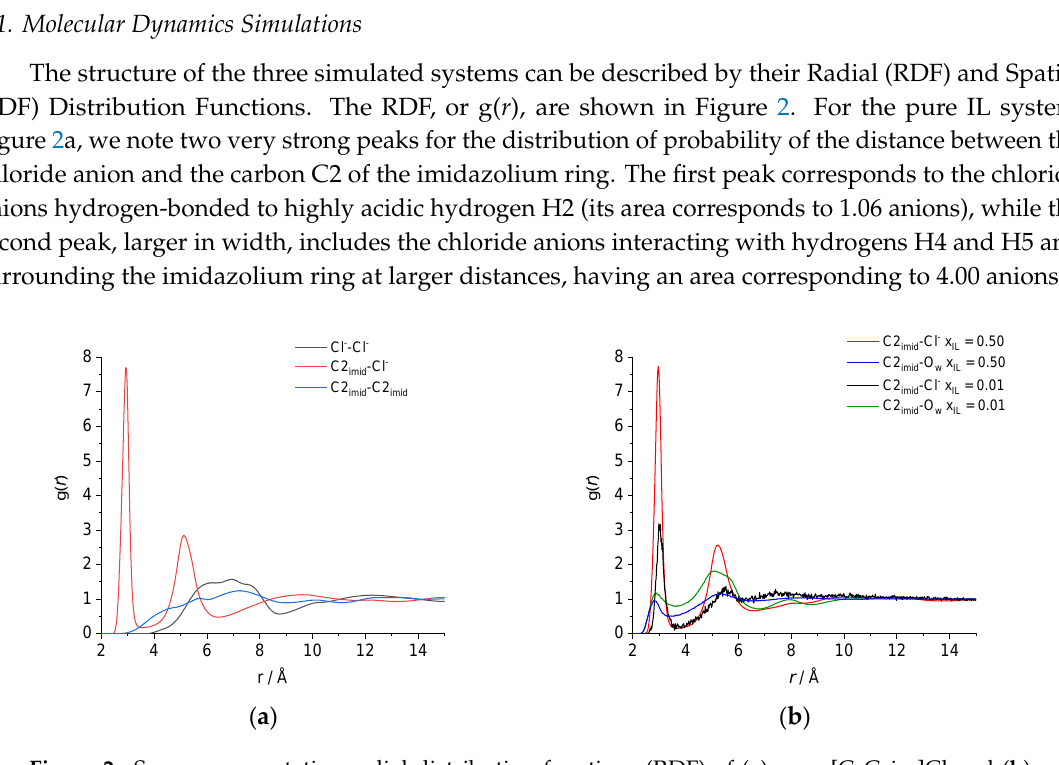
Figure 2. Some representative radial distribution functions (RDF) of ( a ) pure [C 4 C 1 im]Cl and ( b ) [C 4 C 1 im]Cl/water mixtures.